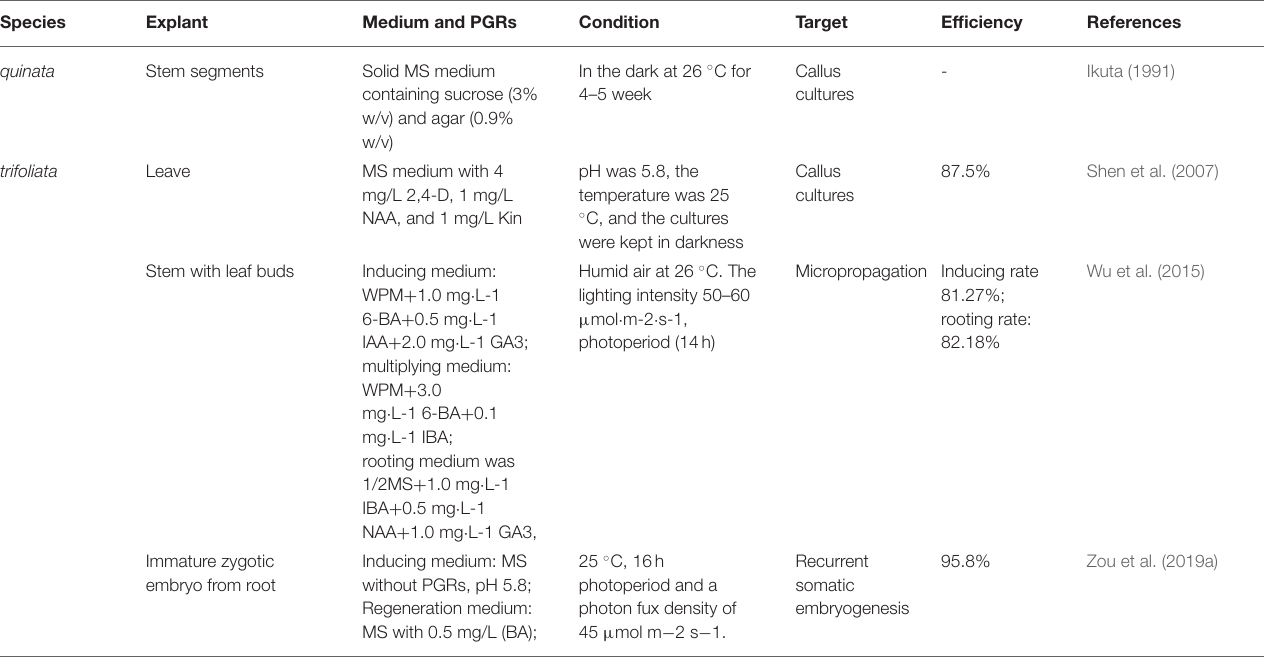
TABLE 4 | Rapid micropropagation in Akebia